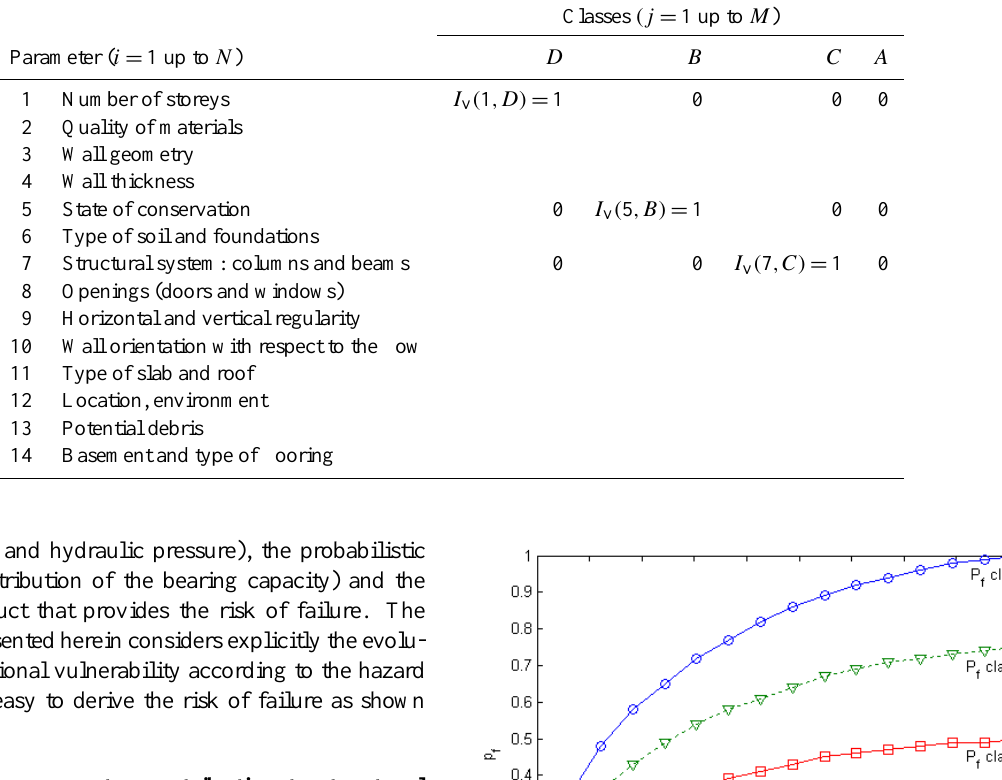
Table 2. Identity matrix for a given masonry construction considered as example.